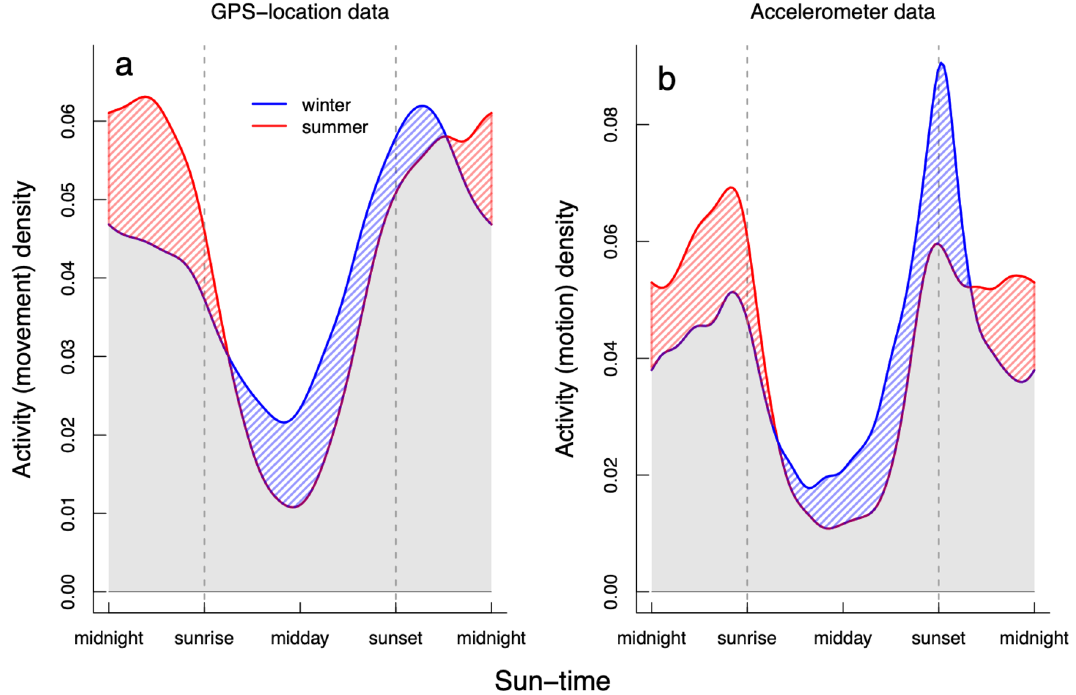
Figure 2. The relative proportion of snow leopard activity across the 24-h cycle for adult males and females during winter (blue) and summer (red) for two types of activity data collected from the GPS-collars ( a = GPS movement data; b = accelerometer activity data). The activity densities on the y-axis have no absolute meaning, but rather are relative measures of probability density calculated from the raw movement data. The time of all observations has been standardised along the x-axis using ‘sun-times’; where the time of observation on each day is calibrated to sunrise, solar-noon (midday) and sunset. These overlap plots show the activity overlap between winter and summer activity (grey) and highlight periods when activity was greater in winter or summer (blue or red shaded polygons,